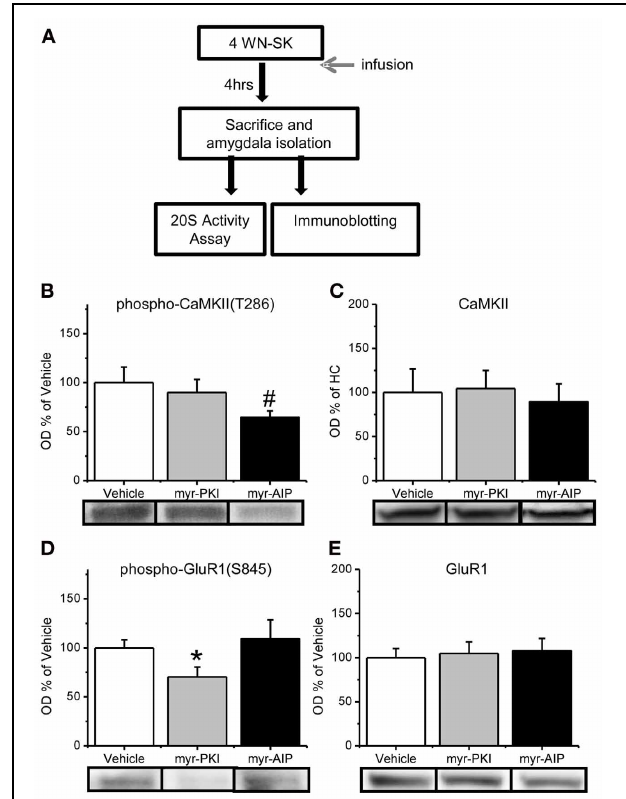
FIGURE 3 | Reduction in CaMKII or PKA activity in the amygdala. (A) Rats received infusions of a PKA inhibitor (myr-PKI), CaMKII inhibitor (myr-AIP) or vehicle immediately after fear conditioning and amygdala tissue was collected 4h later ( n = 8–10 per group). (B–C) Inhibiting CaMKII, but not PKA, tended to reduce the phosphorylation of CaMKII-T286 (B) without affecting total CaMKII levels (C) . (D–E) Inhibiting PKA, but not CaMKII, reduced phosphorylation of GluR1-S845 (D) without affecting total GluR1 levels (E) . ∗ p < 0 . 05 from Vehicle and myr-AIP. # P = 0.06 from Vehicle and